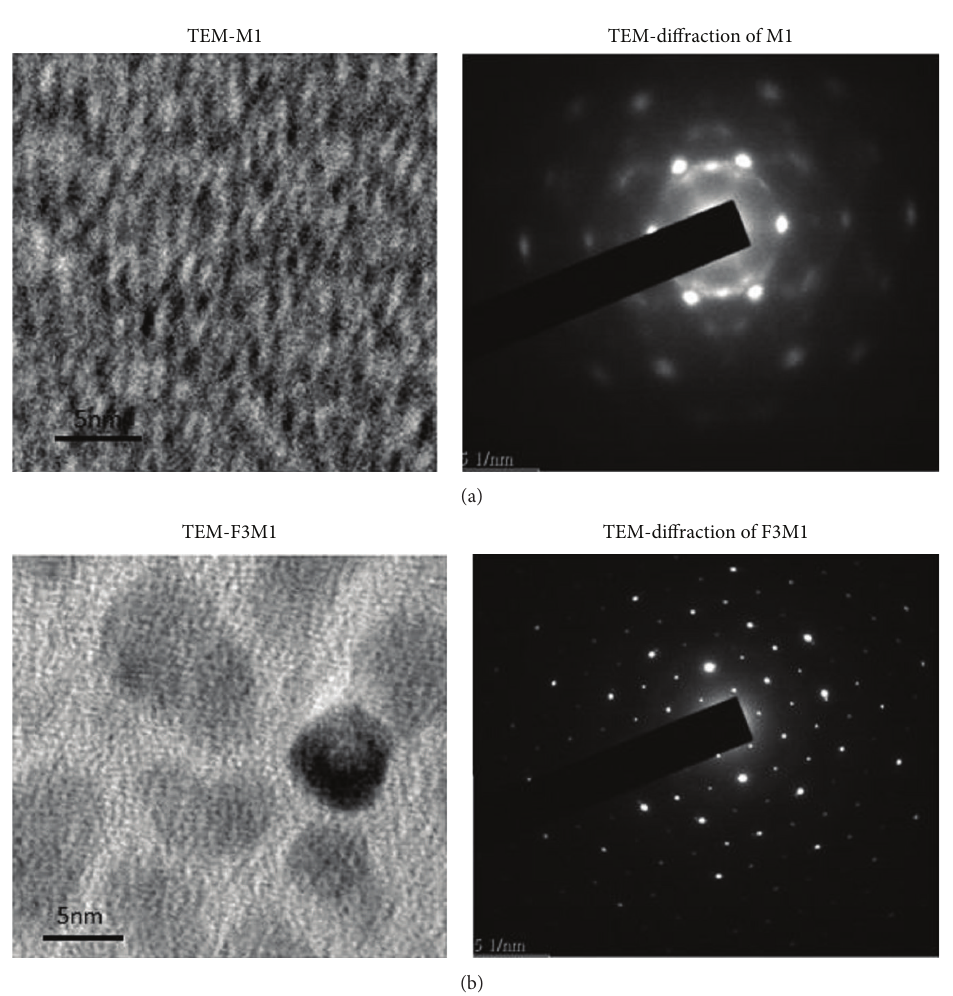
Figure 2: (a) TEM micrograph of MG doped (M1) glass with its diffraction pattern. (b) TEM micrograph of MG-Fe doped (F3M1) glass with its diffraction